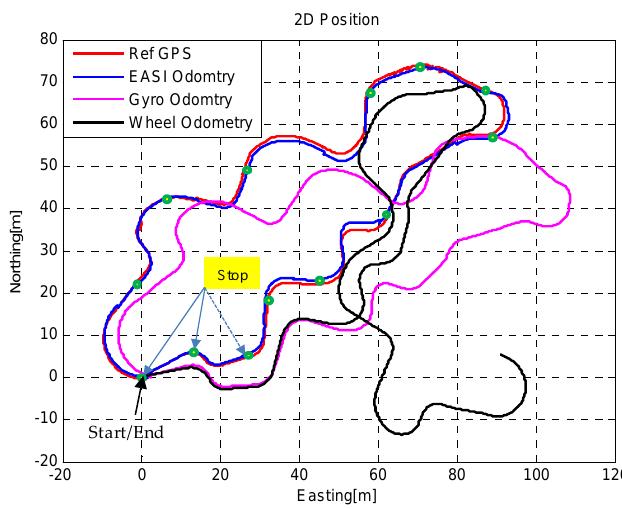
Figure 26. 2D localization plot: Comparison of position estimations using different localization techniques for the planetary rover.